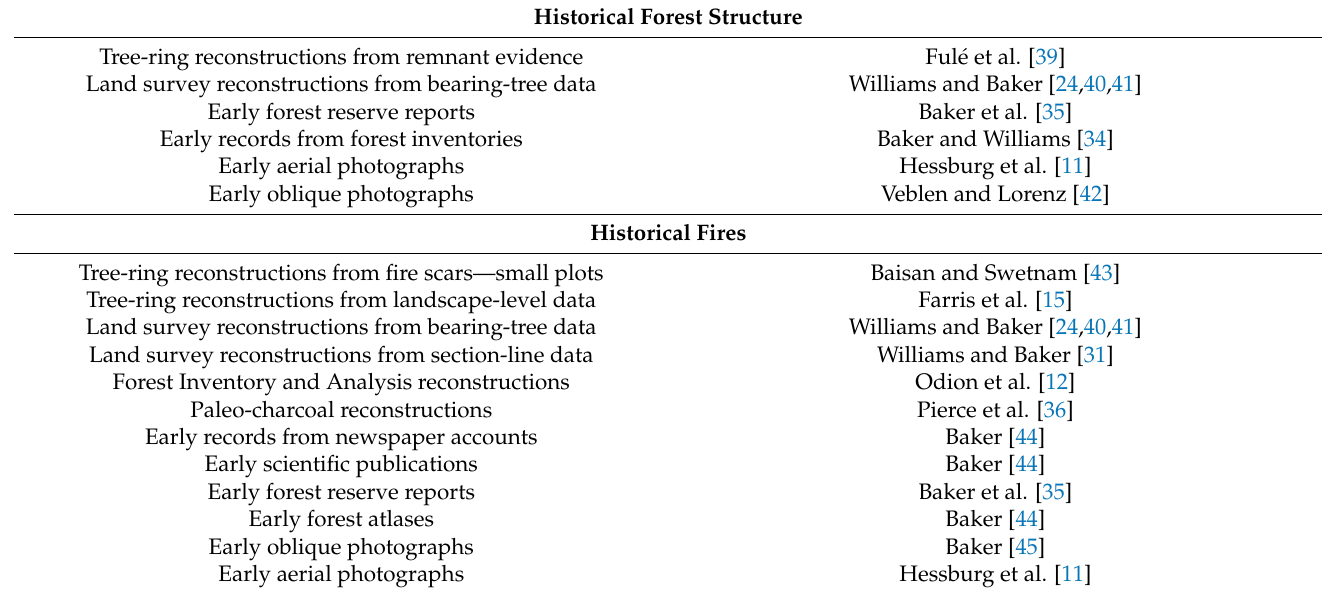
Table 2. Sources of evidence about historical forest structure and fires in dry forests, and selected methods papers and